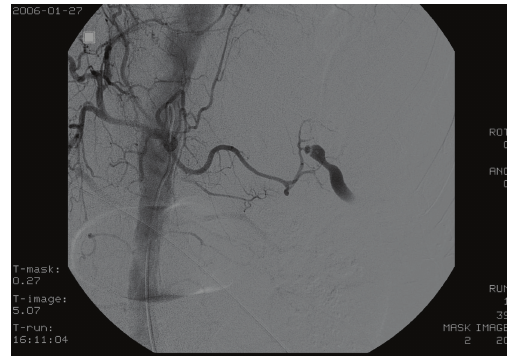
Figure 3: Arteriogram of celiac artery displays a small aneurysm rupture at a branch of splenic artery.